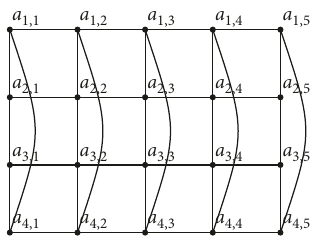
Figure 2: Cylinder grid graph P